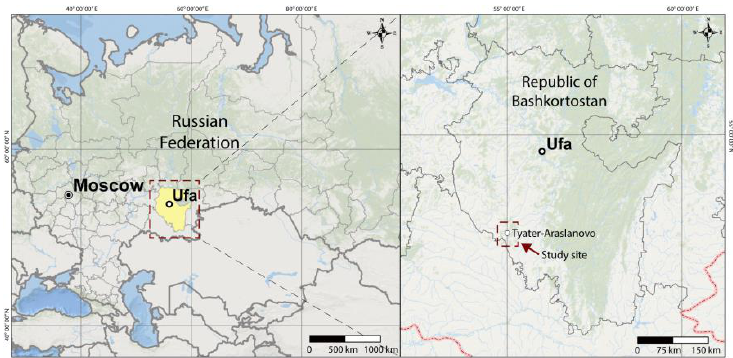
Figure 1. Location of the Tyater-Araslanovo-II Settlement archeological site.